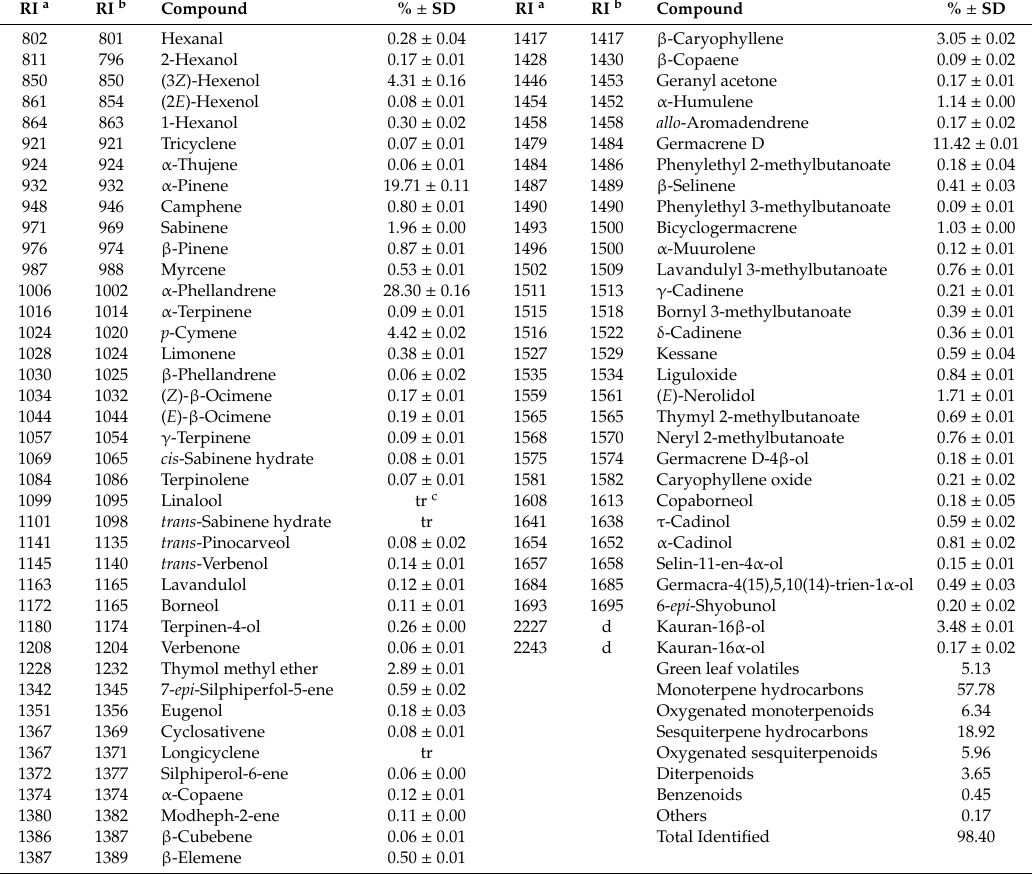
Table 5. Chemical composition of the essential oil of Polymnia canadensis